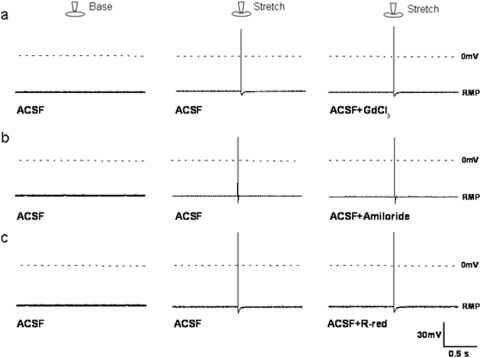
The response of stretch-activated mechanotransduction in neurites to mechanosensitive (MS) channel blockers.Common MS channel blockers were used to probe their effect on AP signaling. A baseline signal for each cell was first recorded with no stimulation provided. This was followed by recording the AP signal following the application of force from an indentation with no channel blocker being used. Next, the blocker was applied to the neurite, and another indentation was made; the AP was recorded during both of these events. (a) The stretch-activated AP was not blocked by GdCl3 (100 µM, n = 8), (b) amiloride (100 µM, n = 8), or (c) ruthenium red (5 µM, n = 8).